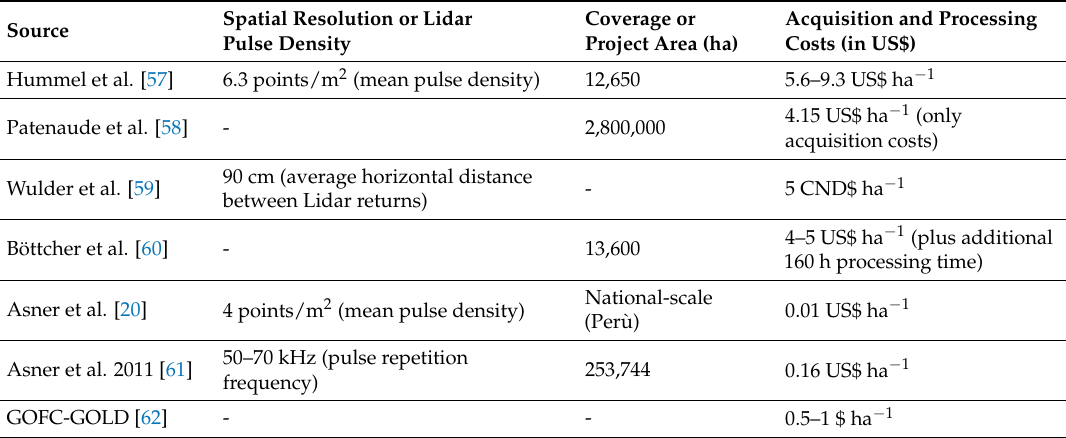
Table 2. Lidar acquisition and processing costs for forest